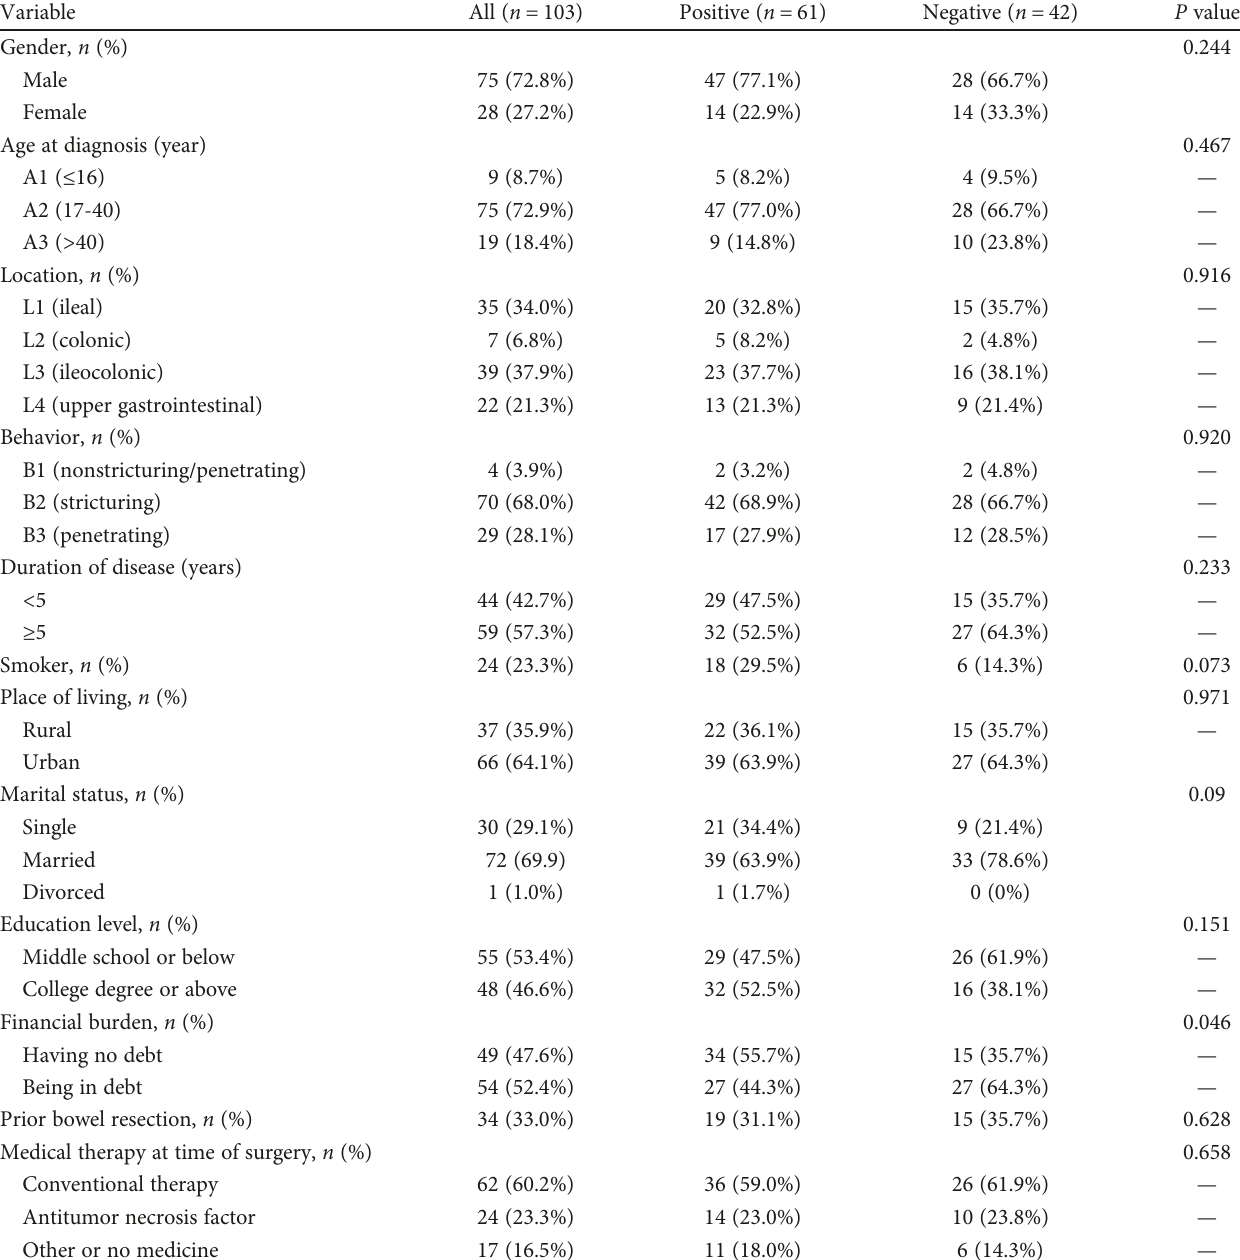
Table 1: The characteristics of the study